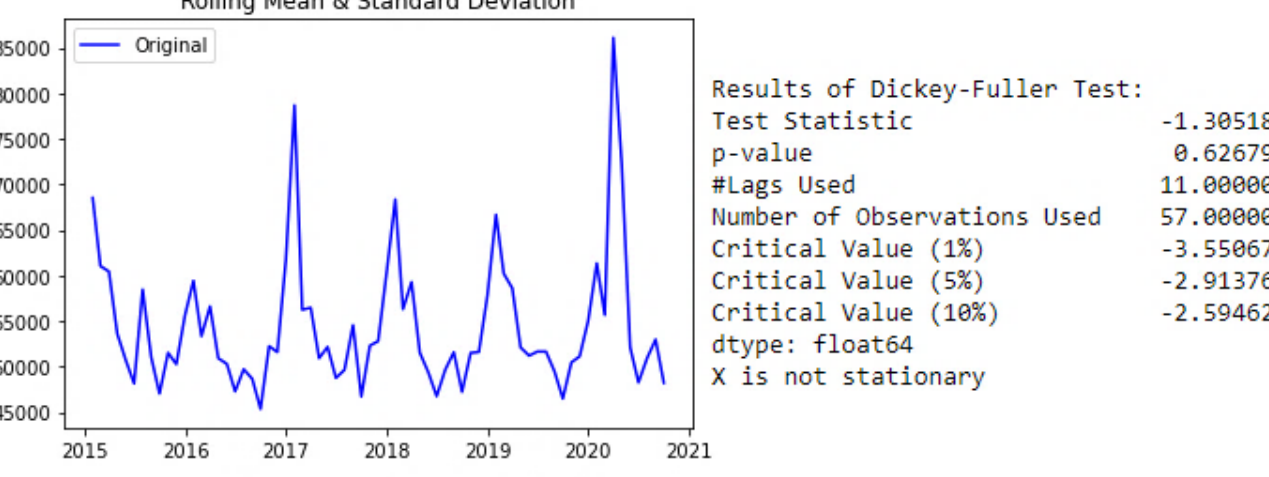
Figure 10. Result obtained from the Dickey-Fuller test applied to the time